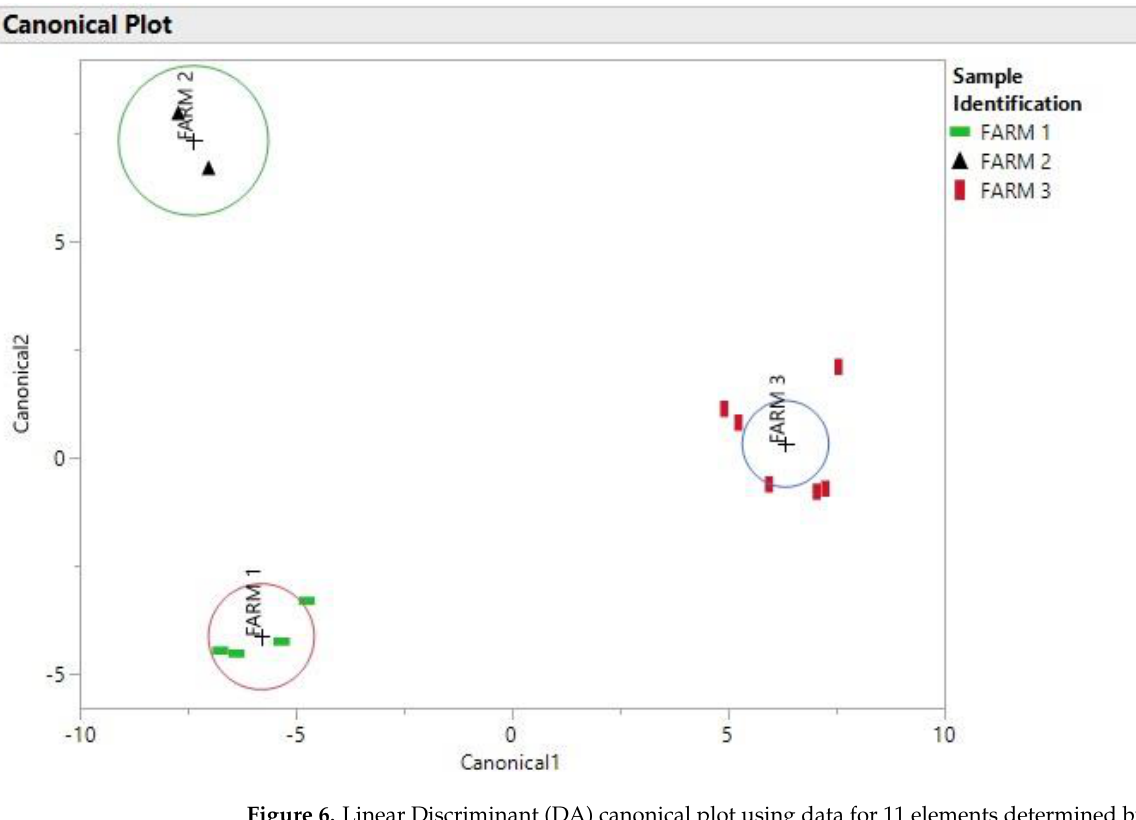
Figure 6. Linear Discriminant (DA) canonical plot using data for 11 elements determined by ICP- MS of the Farm soil